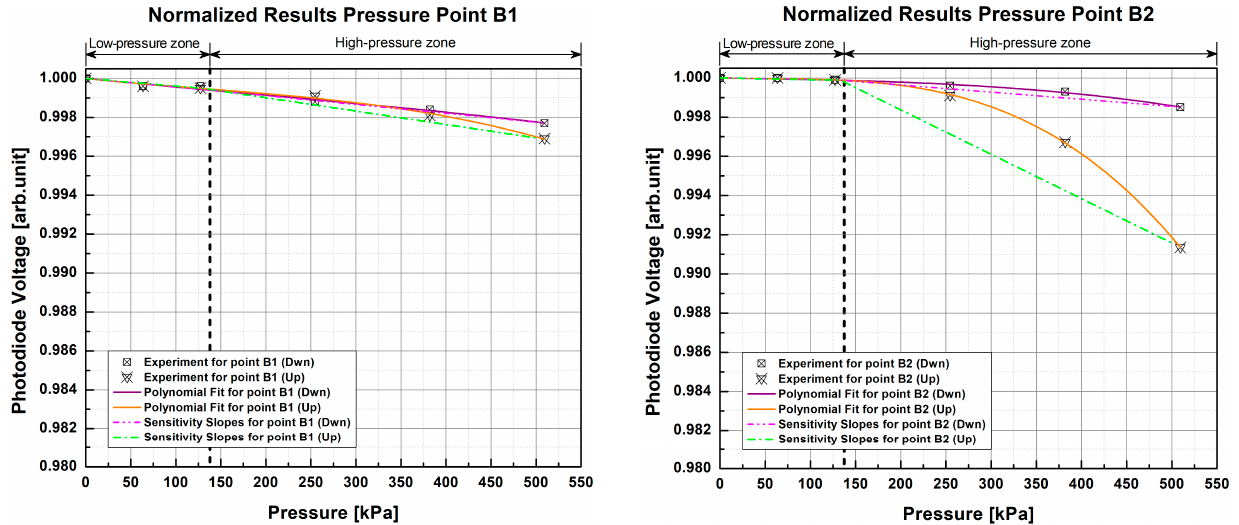
Figure 10. Normalized response curves of the 2 POFs × 2 POFs sample with the low-cost electronics setup at different pressure points. The experimental data points correspond to the average of two test repetitions.